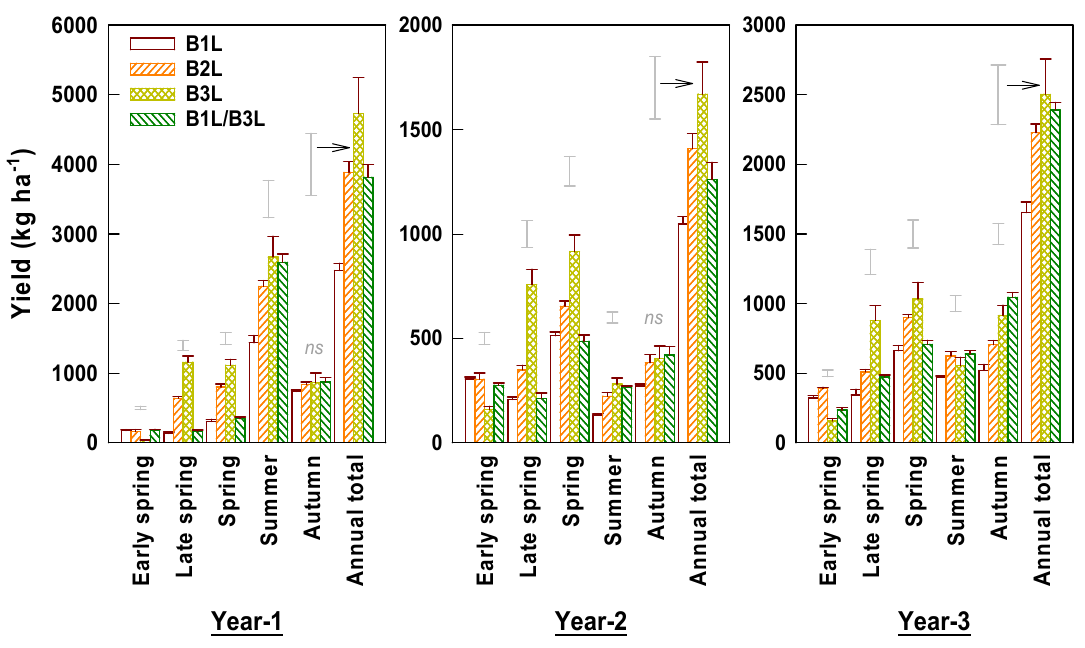
Figure 4. Yields of young shoots harvested under different standards in early and late spring, summer, and autumn over three experimental years (means ± standard errors, n = 4). Single bars without data points located above columns are LSD values indicative of significant ( p < 0.05) differences between harvest standards in the specified season. The symbol ‘ ns’ above columns indicates no significant difference between four harvest standards.